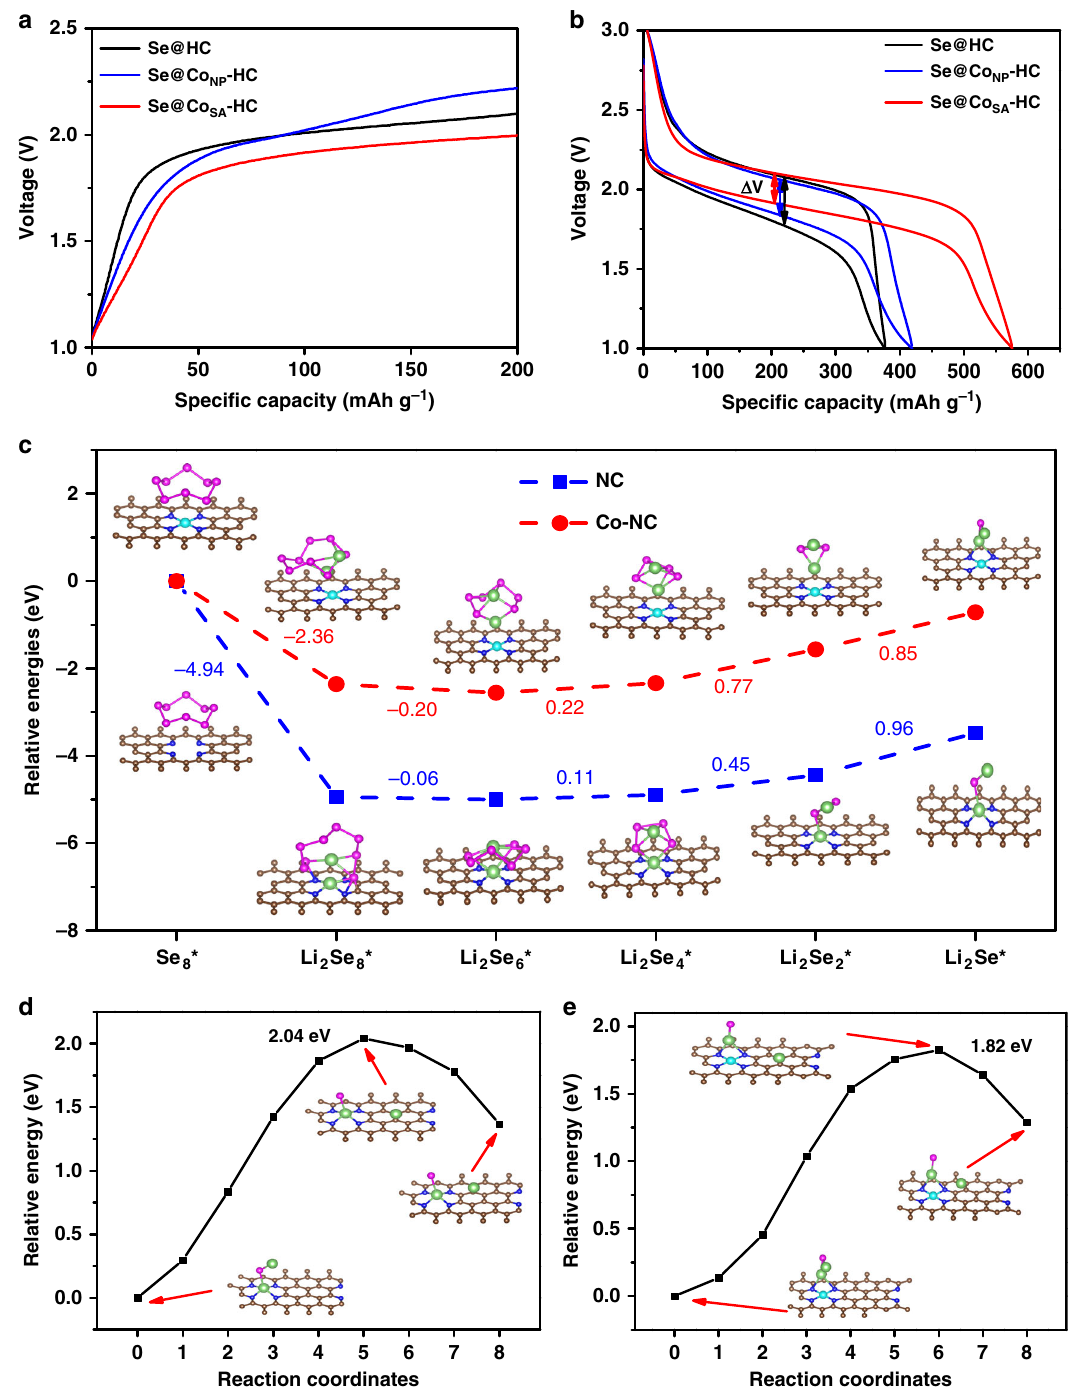
Fig. 6 Catalytic effects of Co SA -HC particles for Li – Se batteries. a The fi rst cycle charge pro fi les at 0.1 C and b discharge-charge pro fi le at 0.1 C of Se@Co SA -HC, Se@HC and Se@Co NP -HC. c Energy pro fi les for the reduction of lithium polyselenides on NC and Co – NC supports (insets: the optimized adsorption conformations of intermediate species on NC and Co – NC substrate). Energy pro fi les of the transformation of Li 2 Se clusters on NC ( d ) and Co – NC ( e ). (The insets are: the initial, transition, and fi nal structures, respectively.) The brown, pink, green, blue, and cyan balls represent C, Se, Li, N and Co atoms,